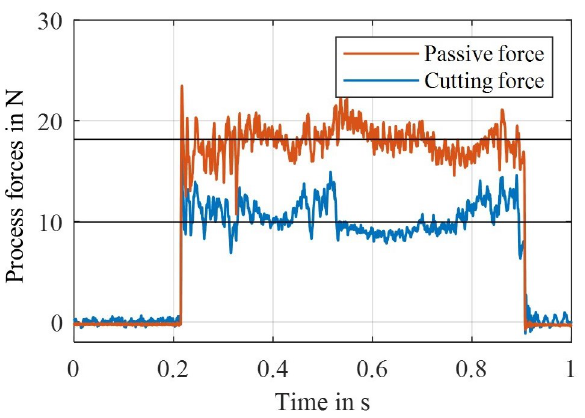
Figure 3. Measured forces recorded with LabView for a single grit scratch on A2024 T351 workpiece ( v c = 200 mm/s and a p = 50